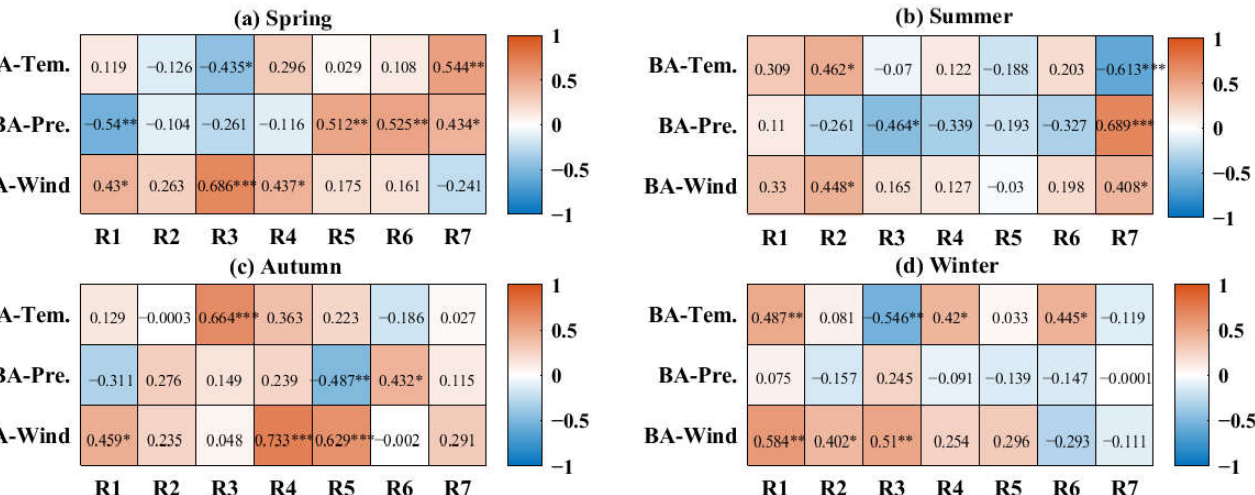
Figure 14. Annual correlation coefficients between BA and temperature, precipitation and wind speed in seven subregions. ** indicates passing the significance test ( p < 0.05), and *** indicates p < 0.01.